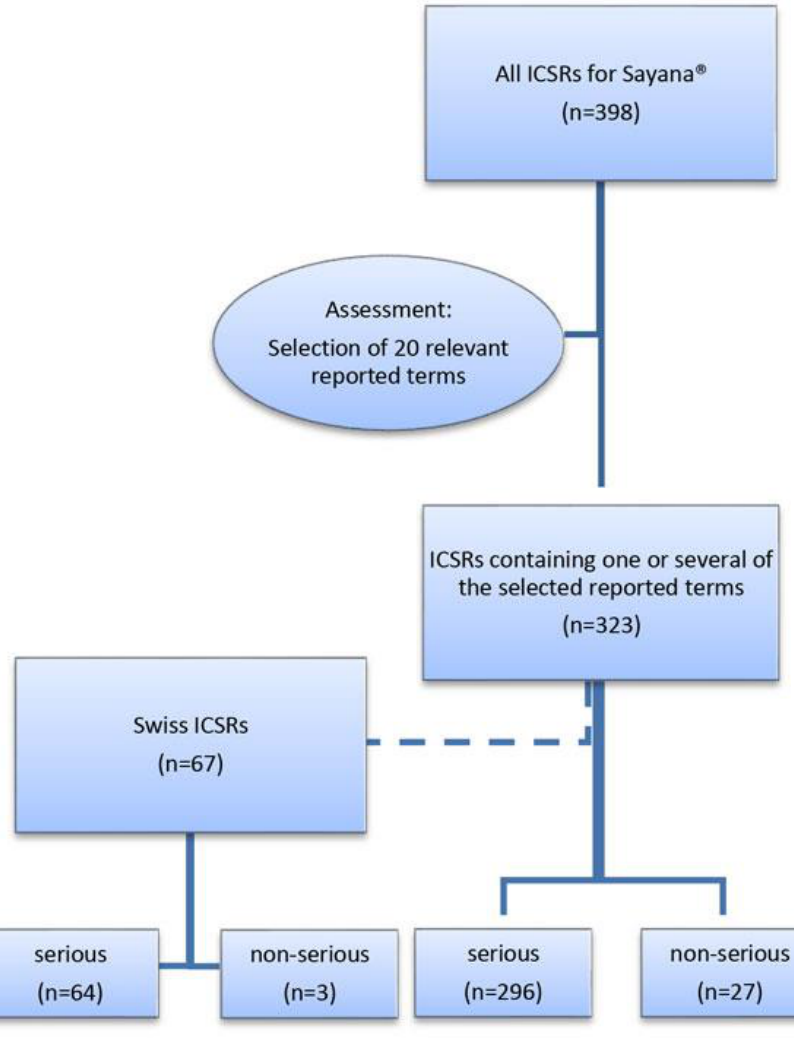
Figure 1: Case selection process: all individual case safety reports (ICRSs) up to 1 January